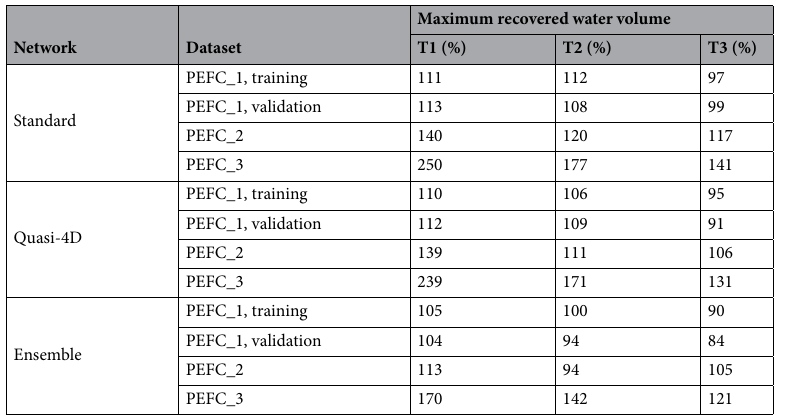
Table 3. Water volume comparison between the volumes at time steps T1, T2 and T3 computed between the SIRT-FBP-MD-D-DIFF classifications and a manual segmentation (ground truth) for each MS-D network design and fuel cell dataset (PEFC_1 training and validation, PEFC_2, PEFC_3). The maximum classified water volume was calculated as a number of water voxels present in the SIRT-FBP-MD-D-DIFF classified volumes compared to the number of ground truth water